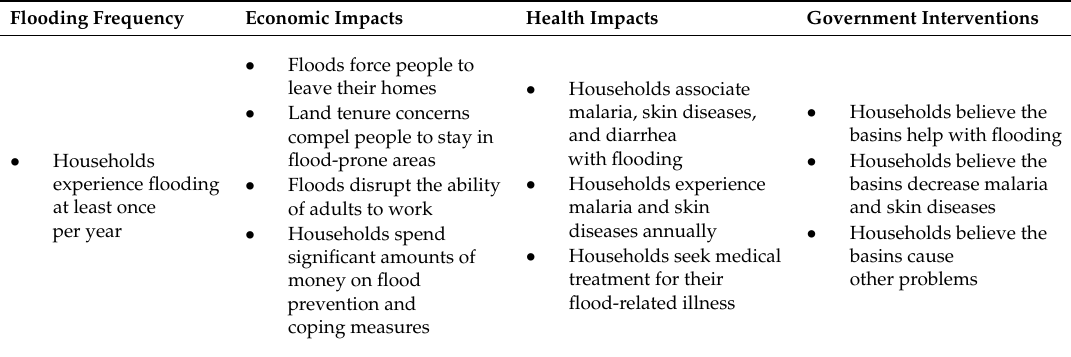
Table 1. Summary of the main research